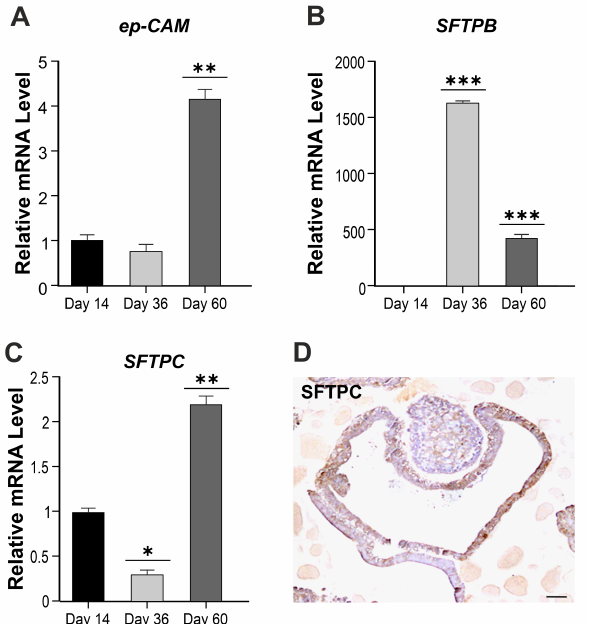
Figure 2. Characterization of hLORGs . ( A – C ) RT–qPCR analyses of lung epithelial cell marker- EPCAM and AT2 cell genes SFTPB , SFTPC in hLORGs at days 14, 36, and 60 of differentiation. Data are representative of three independent experiments and reported as mean ± SD. * p < 0.05, ** p < 0.01, and *** p < 0.001 by Student’s t -test. ( D ) Immunohistochemistry analysis of SFTPC protein in hLORGs at day 60 of differentiation. Scale bar 50 µ